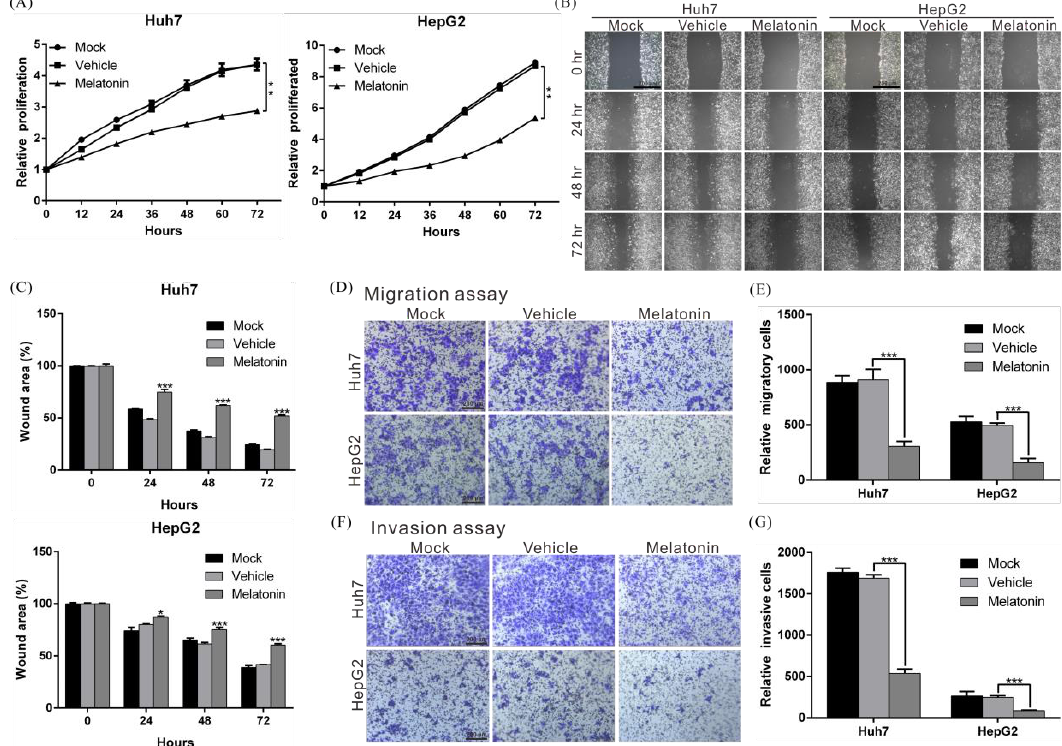
Figure 1. Melatonin suppressed proliferation, migration and invasion capacities in HCC cells. ( A